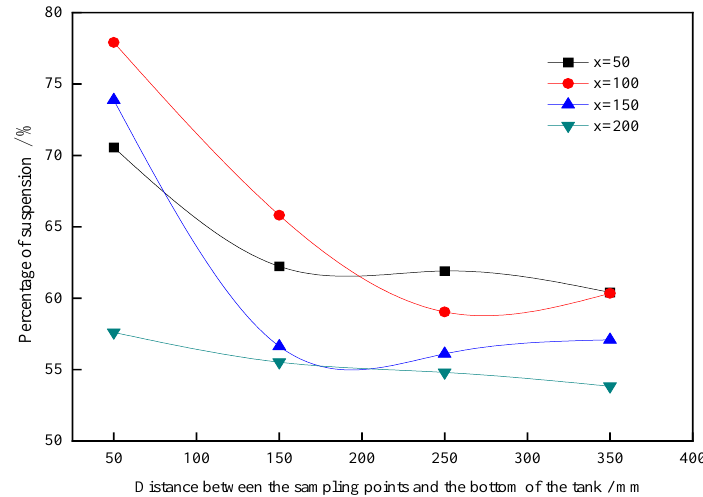
Figure 8. Distribution of material in tank space at preliminary suspension state.